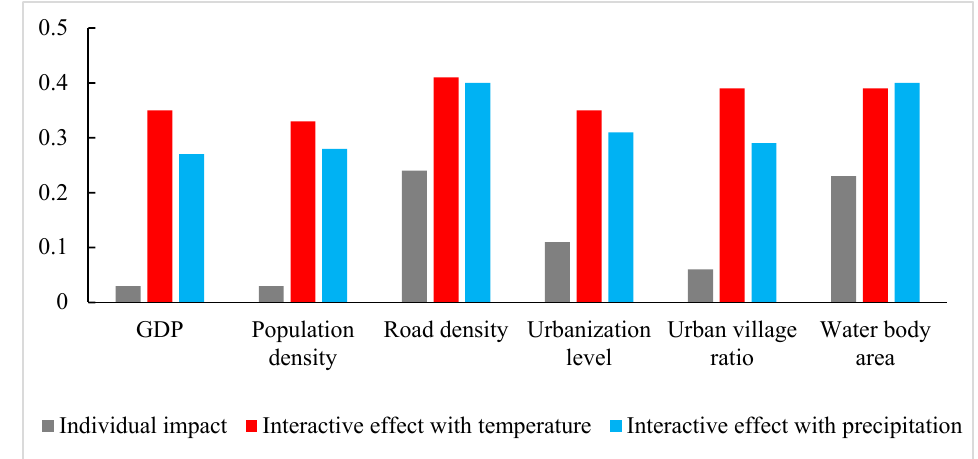
Figure 4. Interactive impact of weather factors and other socio-ecological factors. Gray is the individual impact of GDP, population density, road density, urbanization level, urban village ratio, and water body area. Red is the interactive impact of temperature and the above socio-ecological factors. Blue is the interactive impacts of precipitation and the above socio-ecological factors. All the interactive impacts are statistically significant ( p < 0.05).